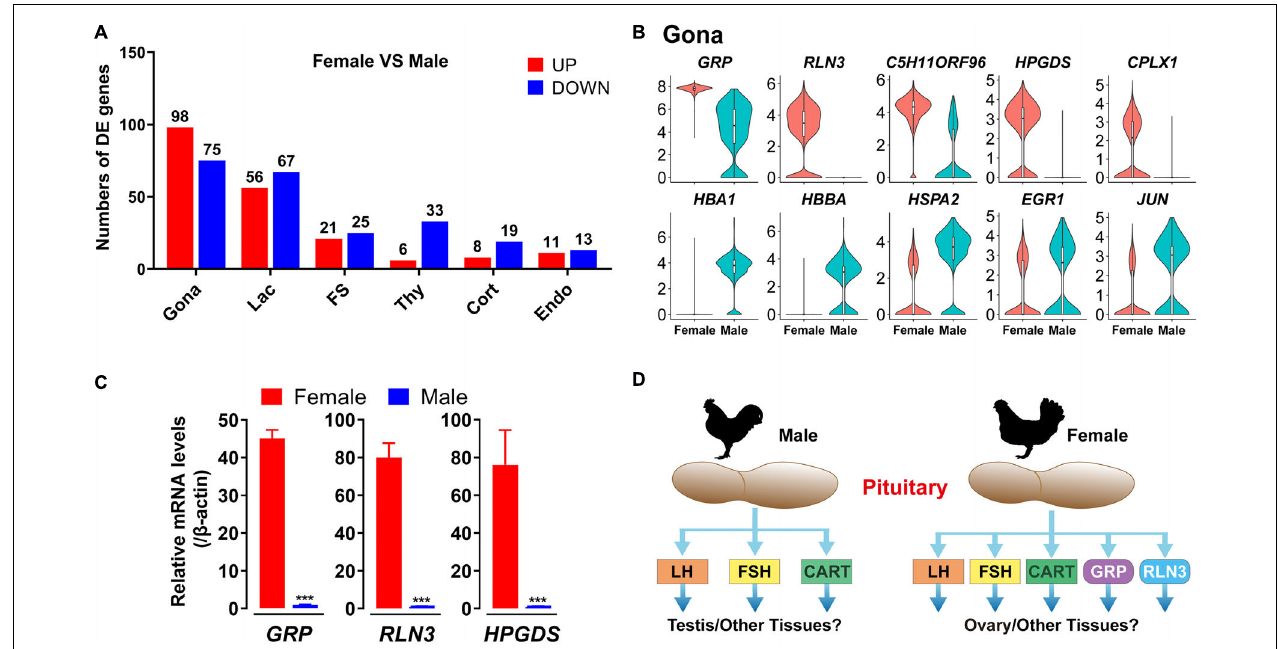
FIGURE 10 | Sexually dimorphic expression of genes in adult chicken male and female anterior pituitary cell clusters. (A) Bar charts presenting the numbers of differentially expressed (DE) genes in each cell cluster in male and female chicken anterior pituitaries. Differences in gene expression level were significant if the adjusted P -value was below the multiple-testing threshold of 0.001 and the absolute log2 expression fold change was above 0.5; (B) Violin plots showing the normalized expression levels of selected genes differentially expressed in gonadotrophs (Gona) of male and female chicken pituitaries. Box plot: median (center black line), interquartile range (white box) and minimum-maximum range (whiskers). (C) qPCR detection of chicken GRP , RLN3 and HPGDS mRNA levels between male and female chicken pituitaries. Each data point represents the mean ± SEM of four laying hens/male chickens ( N = 4). ***, P < 0.001 between two groups. (D) Major endocrine hormones secreted by pituitary gonadotrophs of adult male and female chickens. In male chickens, gonadotroph can abundantly express LHB , FSHB and CART , and thus may produce three major endocrine hormones, which may play important roles in the testis (and other tissues), whereas in hens, gonadotrophs